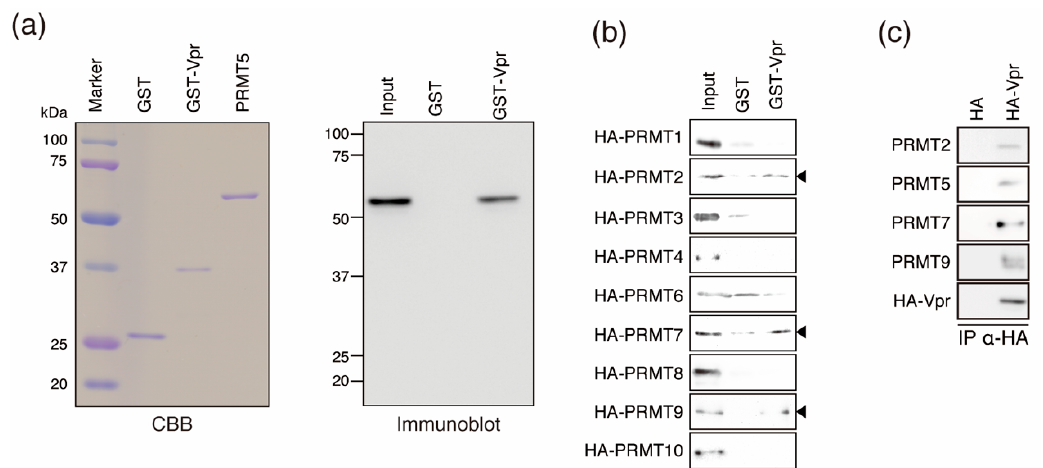
Figure 2. Binding of Vpr by PRMT family members. ( a ) GST pull-down assay using recombinant PRMT5. Purified GST, GST-Vpr, and PRMT5 expressed by E. coli strain BL21 cells were resolved by SDS-PAGE on 10% gels and stained with Coomassie brilliant blue (CBB; left panel). Recombinant PRMT5 after GST removal was incubated with GST-Vpr or GST as a control (immobilized on GST beads) and detected by immunoblotting with an anti-PRMT5 MAbs (right panel). ( b ) GST pull-down assays with other PRMT family members and GST-Vpr. Arrowheads indicate Vpr-binding PRMT proteins (PRMT2, PRMT7, and PRMT9). ( c ) Co-immunoprecipitation using HA-tagged-Vpr (HA-Vpr)-expressing cells. HA-Vpr and HA tag alone were expressed in HeLa cells and co-immunoprecipitated using anti-HA MAbs. PRMT2, PRMT5, PRMT7, and PRMT9 were detected by immunoblotting with antibodies specific to each